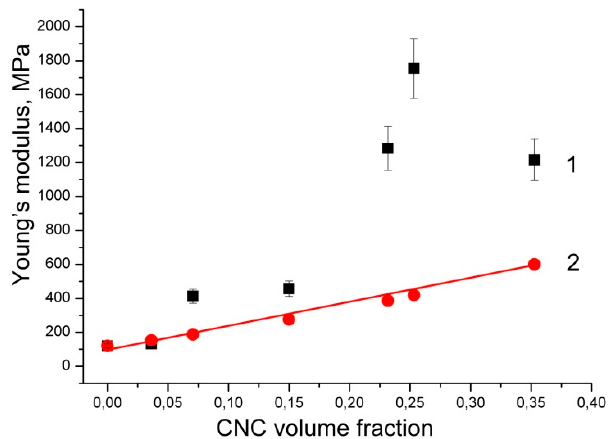
Figure 5. Experimental data (1) and fitting results according to Halpin–Tsai model (2). The error bars are the standard deviations in repeated